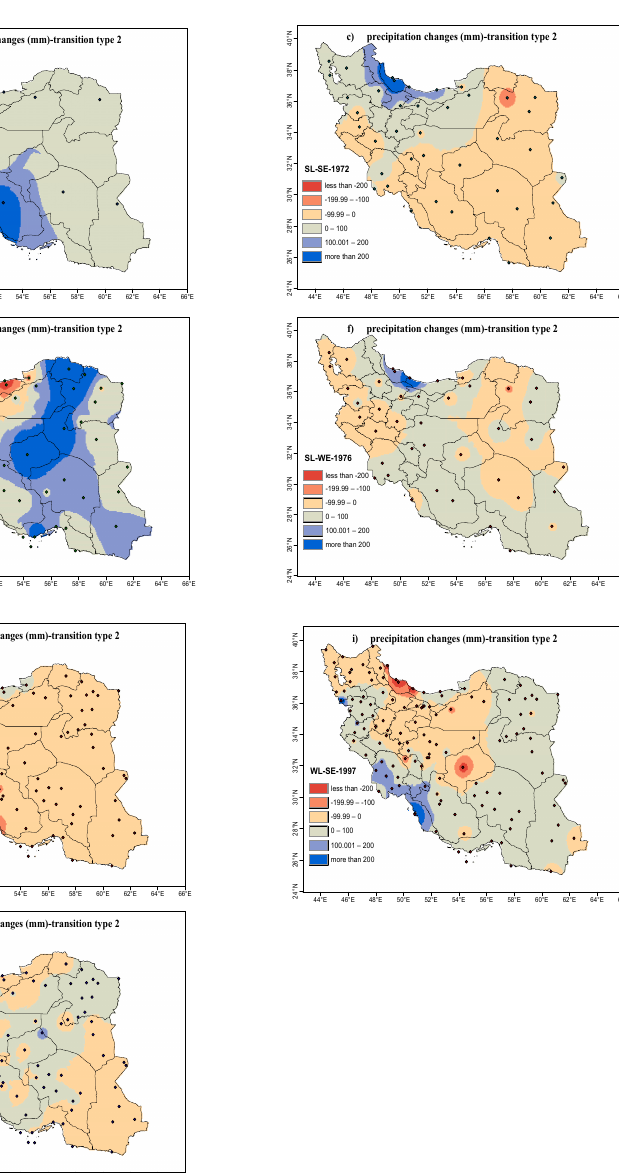
Figure 1. Precipitation anomalies (yearly minus climatology) during all years of ENSO phase transition type 1.